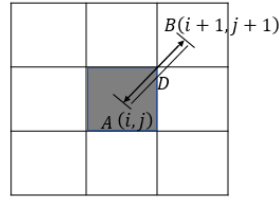
Figure 5. Original area (up) and the rasterized area (down)